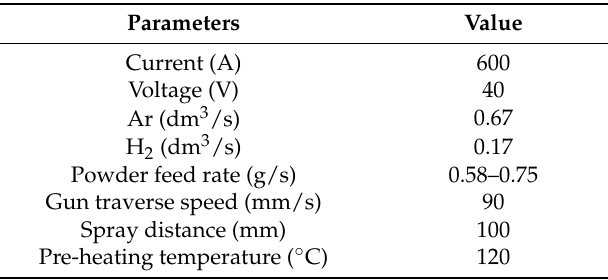
Table 2. Operation parameters of plasma